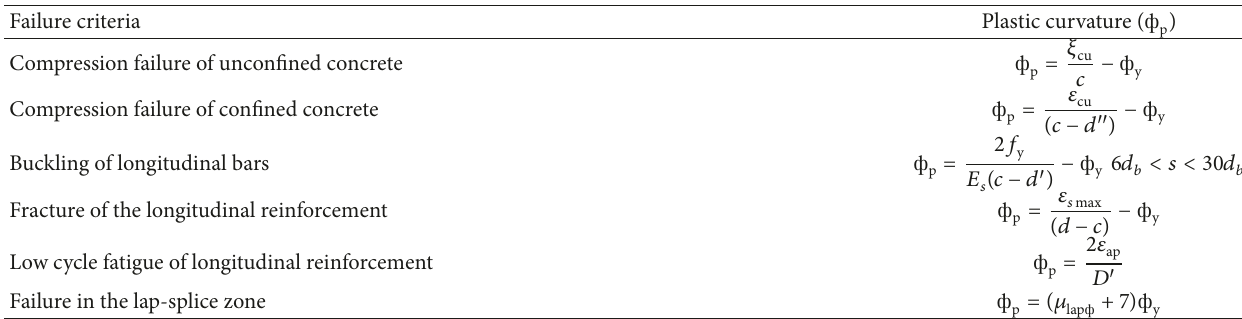
Table 1: Curvature limit